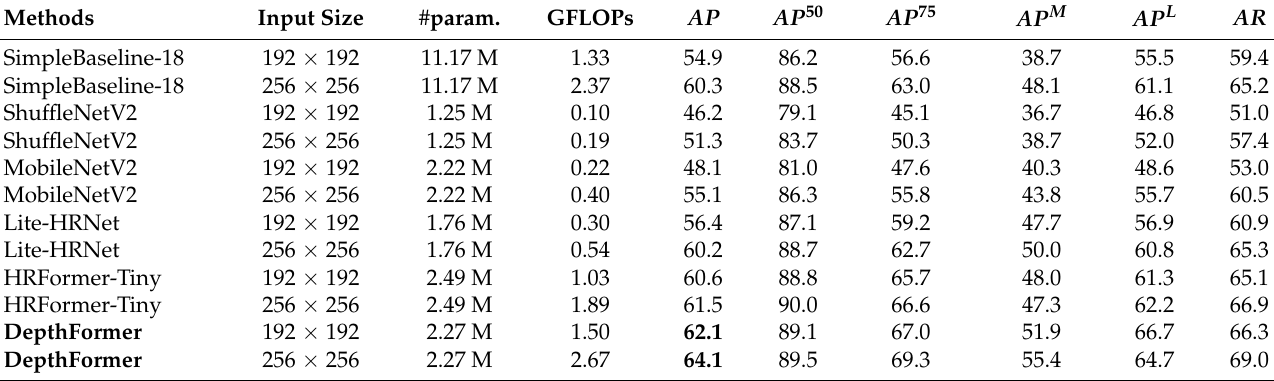
Table 3. Comparison on the AP-10K test set. The volume of parameters and FLOPs for the animal pose estimation network are measured without animal detection and the keypoint